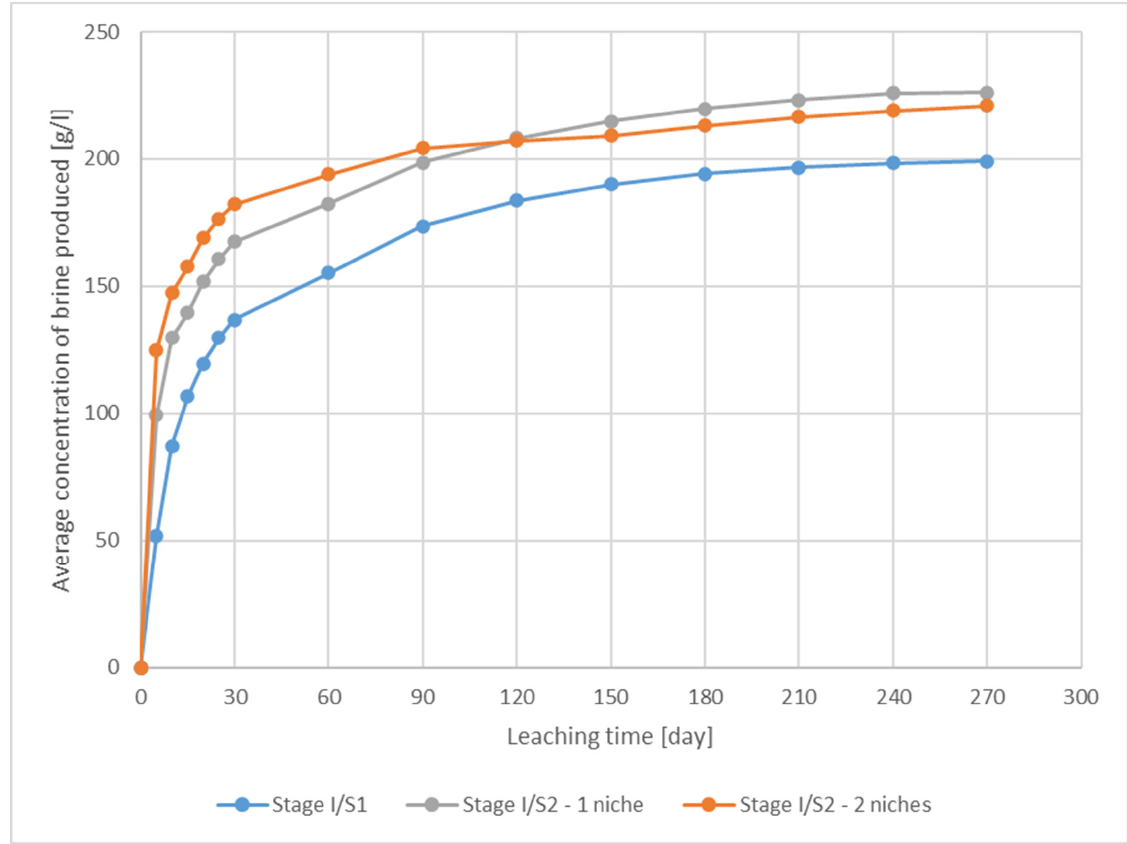
Figure 11. Comparison of the changes in the brine concentration of the produced brine for stage I for different scenarios.